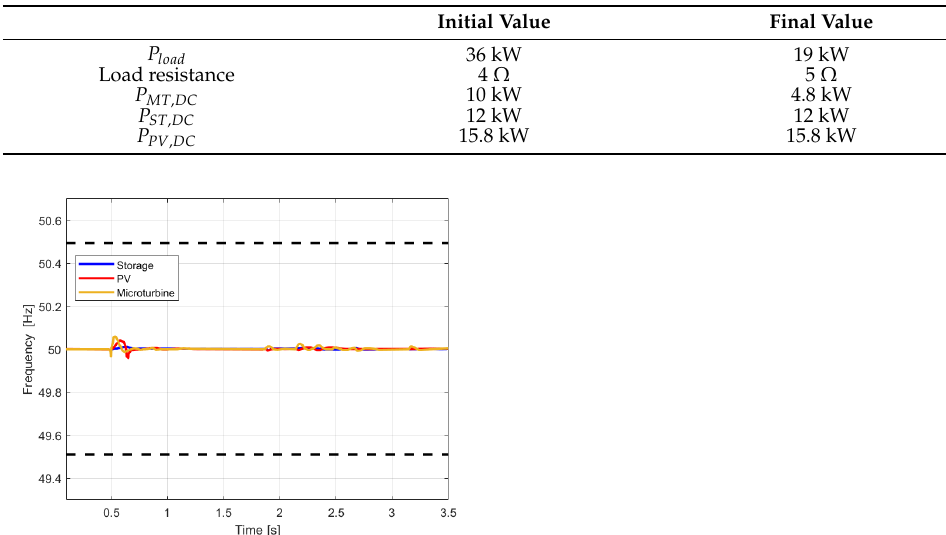
Figure 12. Simulation C: Frequencies. The dashed black lines represent the frequency limits f min and f max .